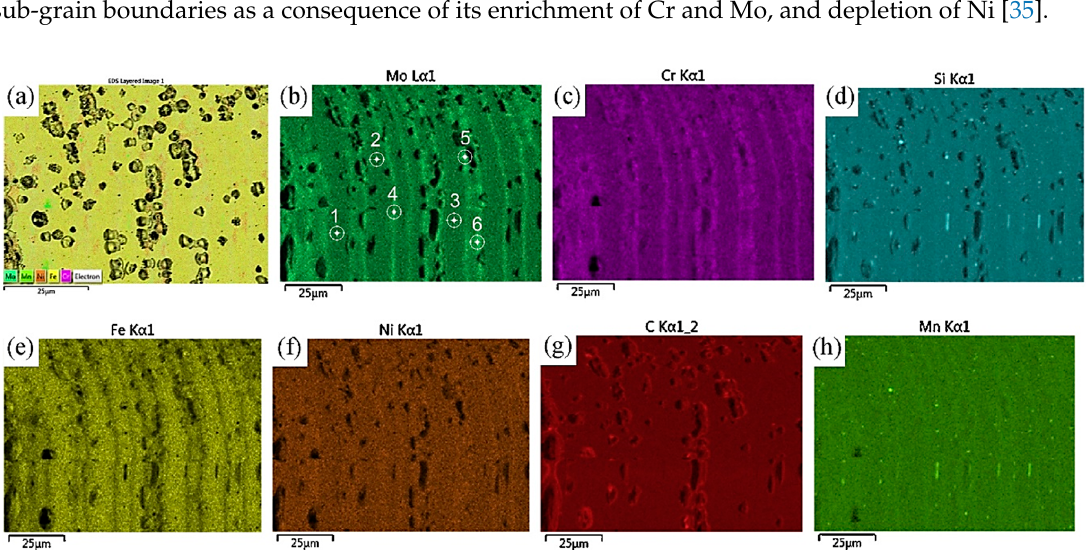
Figure 11. Element mapping for deposition body area: ( a ) layered element image, ( b ) molybdenum and target body, boundary element composition points, ( c ) chromium, ( d ) silicon, ( e ) iron, ( f ) nickel, ( g ) carbon, ( h ) manganese [41].